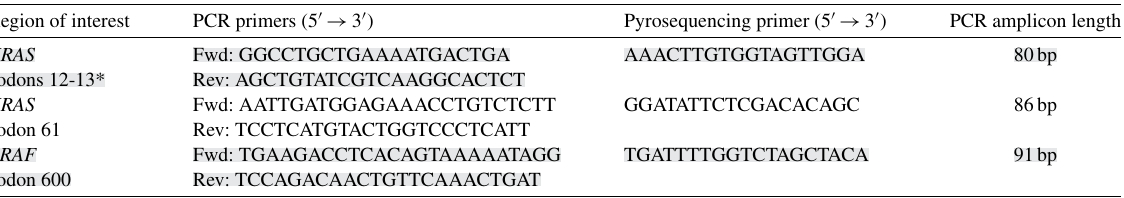
Primer sequences and PCR conditions for amplification and analysis of KRAS and BRAF Region of